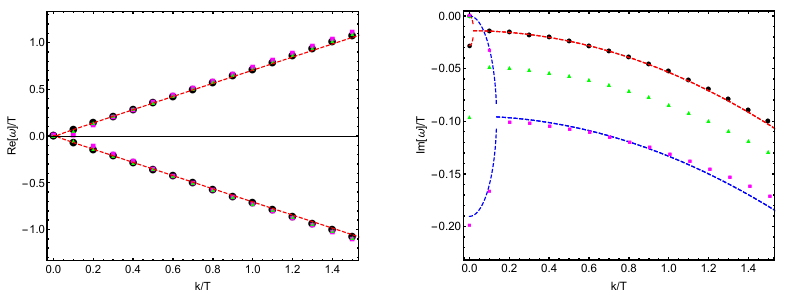
Figure 7 . The dispersion relation of the lowest modes for m 2 = f 0 : 297 ; 0 : 773 ; 0 : 544 g (from black to magenta). The dashed lines are the hydrodynamic formula (3.8) which works well for m=T (cid:28) 1. k < k < k . This is similar to what is already observed in [26]. Increasing the value of 1 2 m=T , the [ k ; k ] interval gets larger and larger until the (cid:12)rst momentum k 1 2